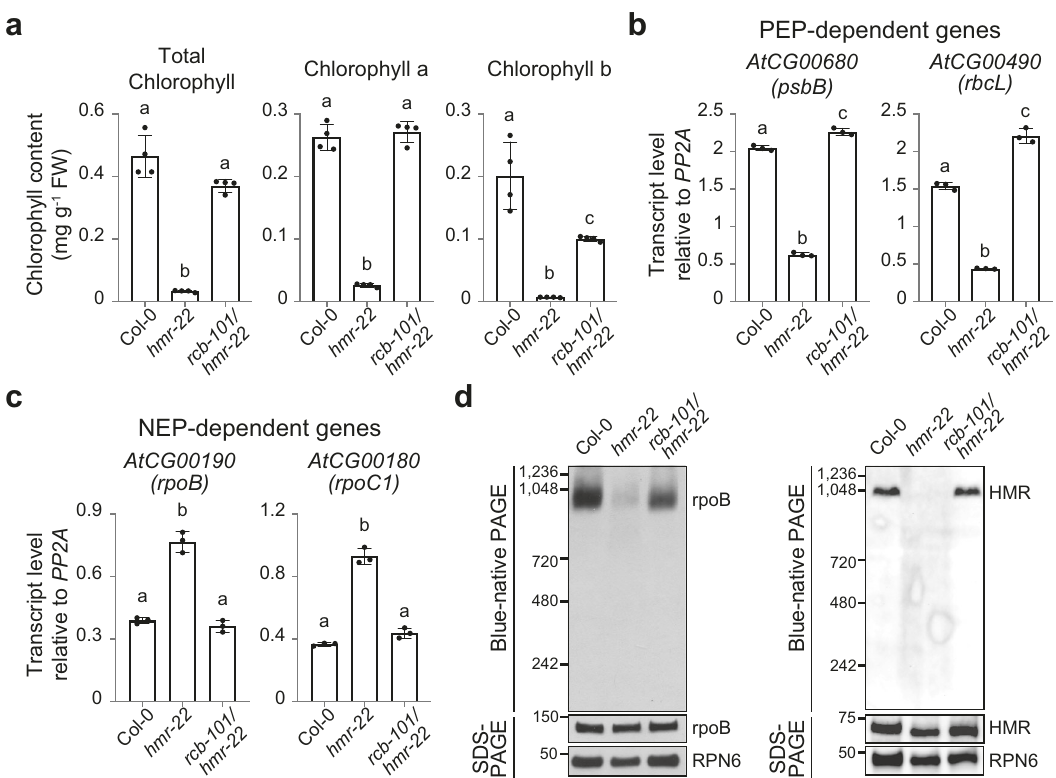
Fig. 4 rcb-101 rescues hmr-22 ′ s defects in chloroplast biogenesis. a Quanti fi cation of total chlorophyll, chlorophyll a, and chlorophyll b in 4-d-old Col-0, hmr-22 , and rcb-101/hmr-22 seedlings grown in 10 μ mol m − 2 s − 1 R light at 21 °C. b , c qRT-PCR analyses of two PEP-dependent genes, psbB and rbcL ( b ), and two NEP-dependent genes, rpoB and ropC1 ( c ), in 4-d-old Col-0, hmr-22 , and rcb-101/hmr-22 seedlings grown in 10 μ mol m − 2 s − 1 R light at 21 °C. Transcript levels were calculated relative to those of PP2A . For a , b , c , error bars represent the s.d. of three ( b , c ) or four ( a ) biological replicates. The centers of the error bars represent the mean values. Different letters denote statistically signi fi cant differences between the samples (ANOVA, Tukey ’ s HSD, p < 0.01, n = 3 or 4 biological replicates). d Immunoblots showing the level of the PEP complex (blue-native PAGE) and the levels of rpoB (left panel) or HMR (right panel) (SDS-PAGE) in 4-d-old Col-0, hmr-22 , and rcb-101/hmr-22 seedlings grown in 10 μ mol m − 2 s − 1 R light at 21 °C. RPN6 was used as a loading control. The immunoblot experiments were independently repeated at least three times, and the results of one representative experiment are shown. The source data of the chlorophyll measurements in ( a ), the qRT-PCR data in ( b , c ), and the immunoblots in ( d ) are provided in the Source Data fi the idea that the effect of RCB A275V (RCB101) relies on the presence of HMR D516N (HMR22), implying a direct interaction between RCB and HMR. To test this hypothesis, we performed reciprocal co-immunoprecipitation (Co-IP) assays using two previously reported transgenic lines, RCB-HA-His/rcb-10 27 and HMR-HA/hmr-5 51,53 , to test a possible interaction between RCB and HMR in vivo. The results of these experiments showed that either HA-tagged RCB or HA-tagged HMR could pulldown the other, indicating that RCB and HMR are associated with each other in vivo (Fig. 6c, d). To further examine whether RCB interacts with HMR directly, we performed in vitro GST pull- down assays using GST-tagged full-length HMR (GST-HMR) and in vitro transcribed and translated HA-tagged RCB (HA-RCB) (Fig. 6e). GST-HMR, but not GST alone, could pulldown HA- RCB (Fig. 6f), con fi rming that RCB interacts directly with HMR in vitro. HMR contains an N-terminal transit peptide 50 , a glutamate-rich region, PHYA-interacting regions 1 and 2 (PIR1 and PIR2) 53 , and the C-terminal 9aaTAD 51 (Fig. 6e). To deter- mine which region of HMR confers the interaction with RCB, we tested two N-terminal HMR truncation fragments: GST- HMR Δ 115, which contains the glutamate-rich region, PIR2, and 9aaTAD, and GST-HMR Δ 251, which contains PIR2 and the 9aaTAD. Only GST-HMR Δ 251, but not GST-HMR Δ 115, could pulldown HA-RCB (Fig. 6f). These results indicate that the C- terminal half of HMR, including PIR2 and the 9aaTAD, is